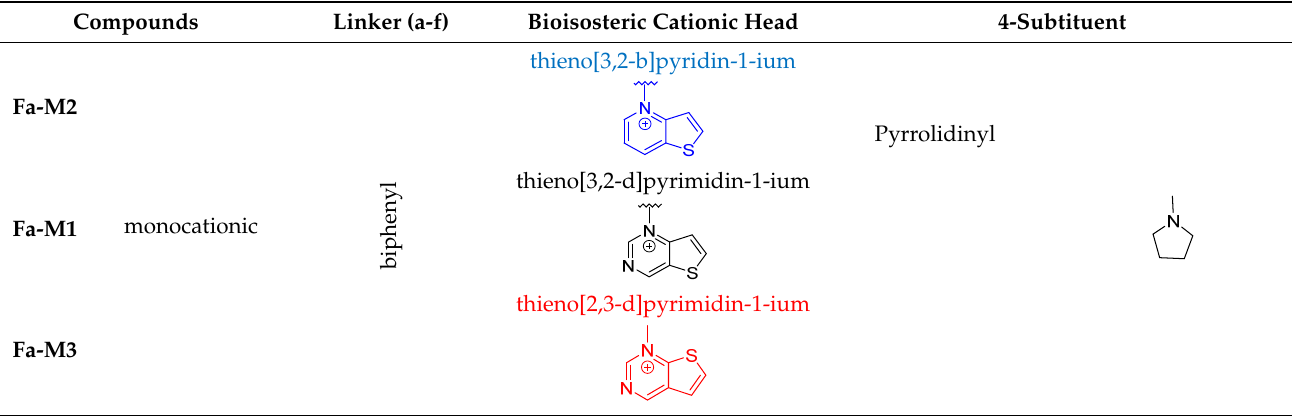
Table 1. Final Compounds synthetized and evaluated. The different bioisosteric cationic head are showed in blue, black and red respectively.